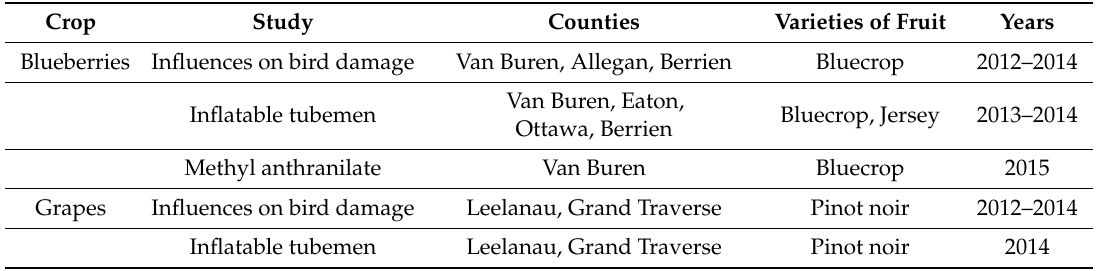
Table 1. Summary of years, locations of studies in Michigan, and varieties of